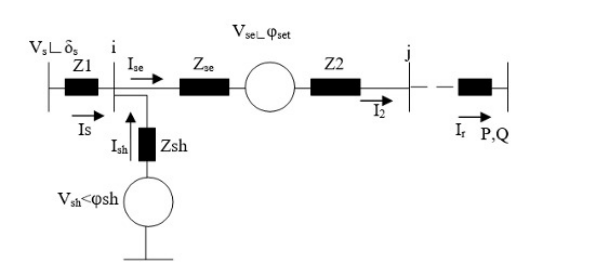
Figure 1. Single Line Diagram of Power Transmission System with